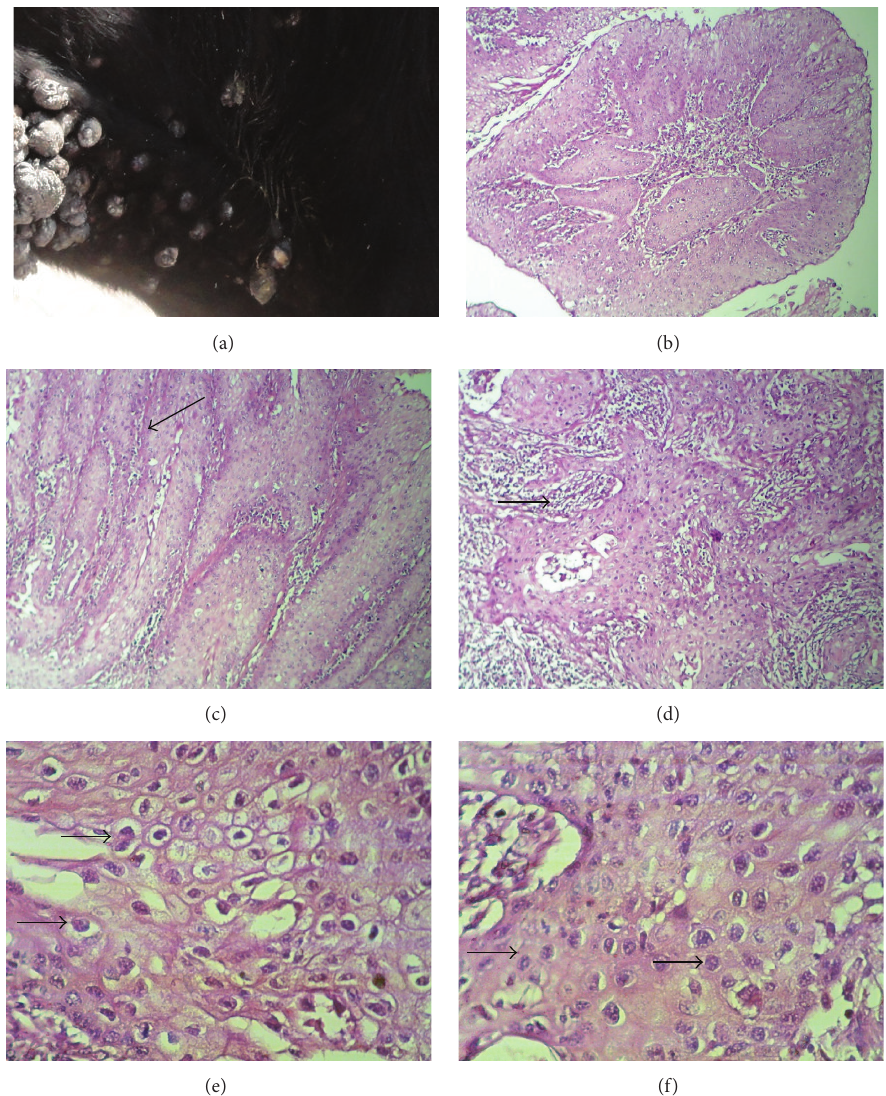
Figure 1: Cutaneous papillomas of the skin. (a) Neck, cow. Multiple exophytic, irregular verrucous papilloma masses arising in the skin. (b) Histopathological section showing papillary projections composed of a hyperkeratotic epidermis with a central collagenous core (10x). (c) Interdigitated epidermal and dermal papillary projections (shown by arrows, 10x). (d) Fibroblast proliferation, collagen deposition, and lymphocyte infiltration (shown by arrows, 10x). (e) Koilocytes (arrows) and keratinocytes with swollen perinuclear halos (40x). (f) Koilocytes with clear cytoplasm and pyknotic nuclei (shown by arrows, 40x, stained with H&E).